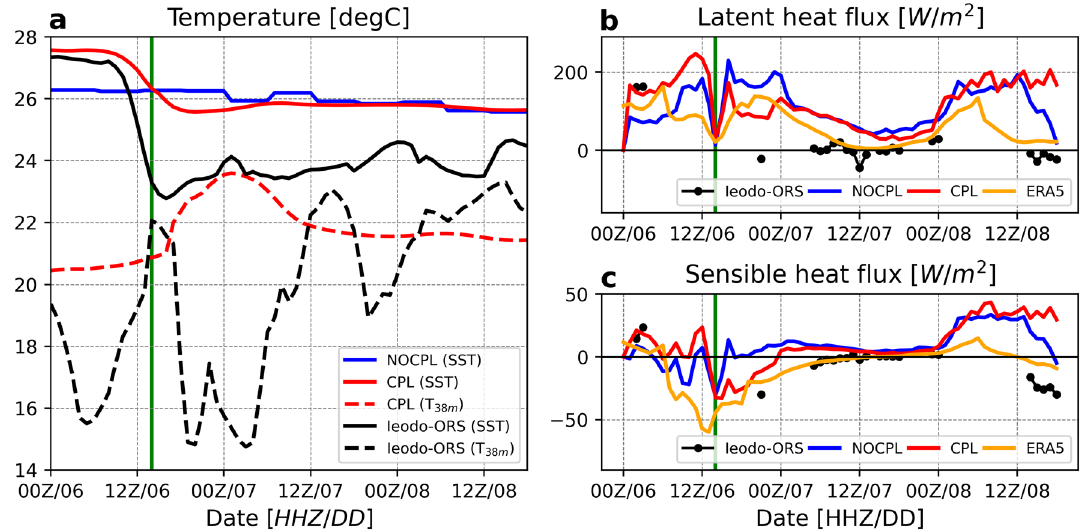
Figure 1. Time series of the ( a ) sea surface temperature (SST), ( b ) latent heat flux, and ( c ) sensible heat flux for observation in Ieodo ORS (black) and simulation results in NOCPL (blue) and CPL (red). The vertical thick green line denotes when the TC center was closest to the Ieodo ORS at 15Z on September 6, 2019. The T 38m was the bottom water temperature at a depth of 38 m. The yellow lines in the right panels were from ERA5